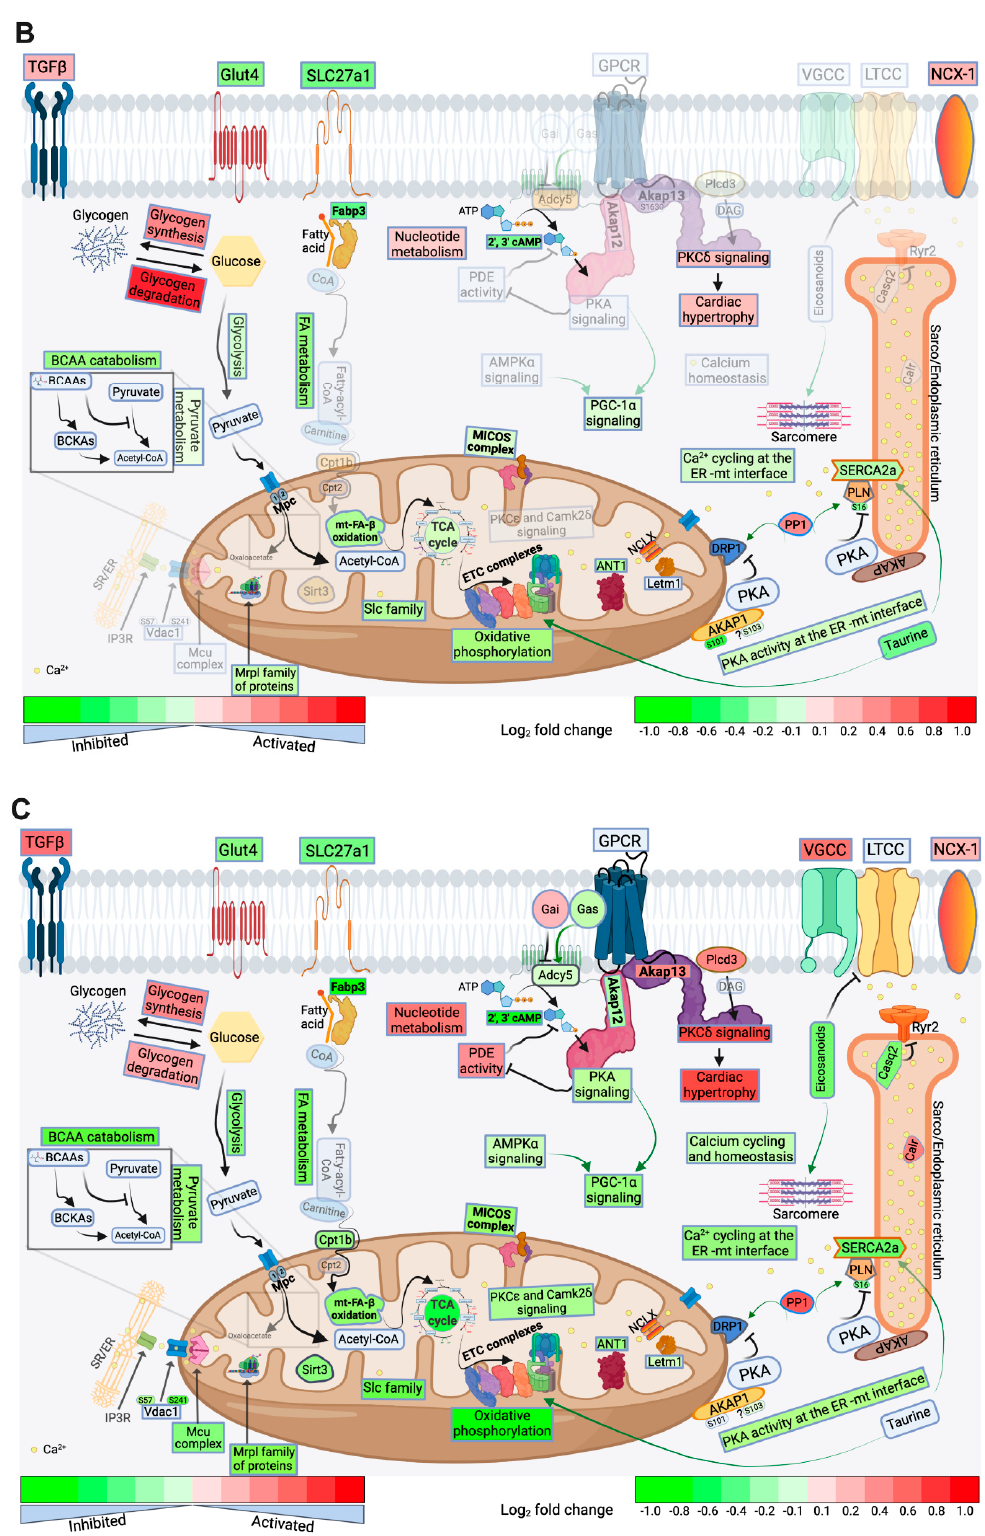
Figure 8. Schematic drawing highlighting metabolic pathways, calcium cycling, and implicated signal- ing pathways in Sham ( A ), and their directional change in MOD vs. Sham ( B ), and SHF vs. Sham ( C ). Green arrows promote pathway or activity. Rectangles show signaling pathways or proteins that were inhibited or down-regulated (green), respectively, and those that were activated or up-regulated